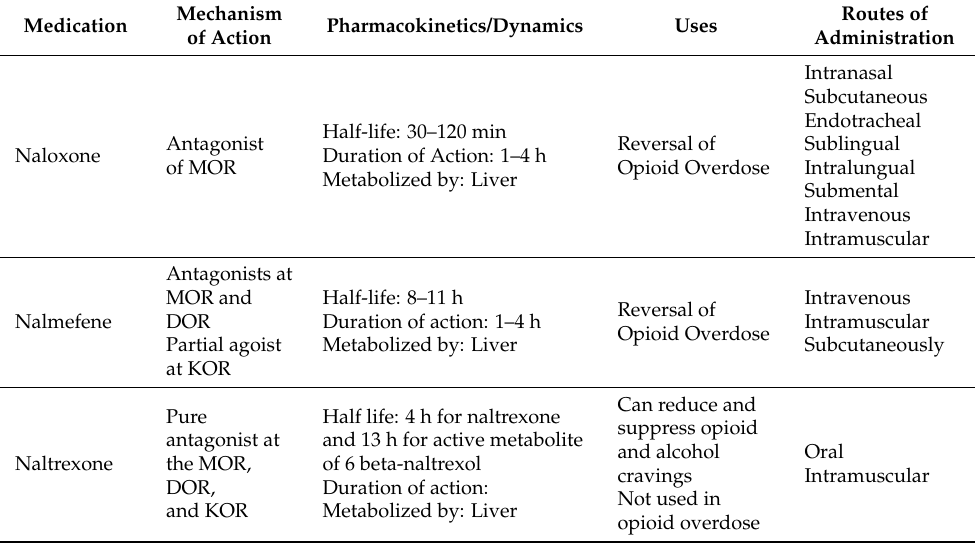
Table 1. The comparison of naloxone, nalmefene, and